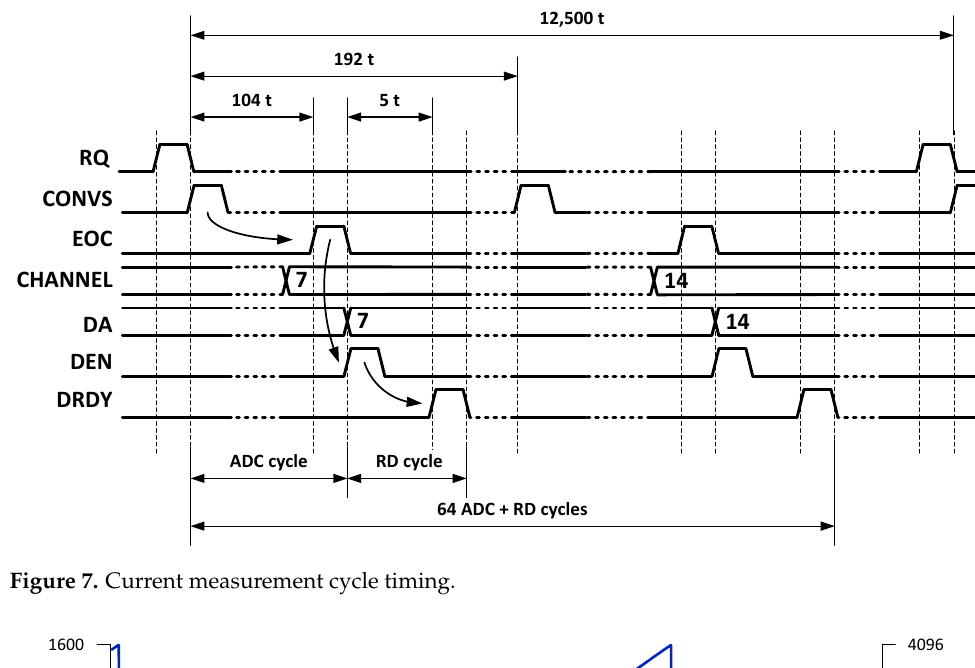
Figure 6. Windings current measurement unit based on integrated XADC.